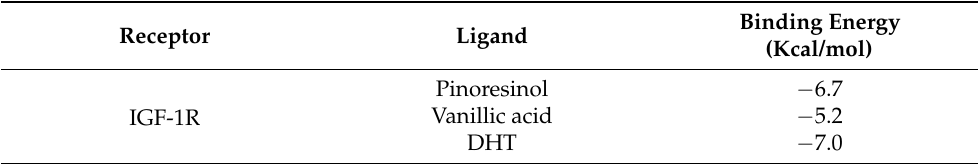
Table 1. Results of docking simulations of two active chemicals (pinoresinol and vanillic acid)